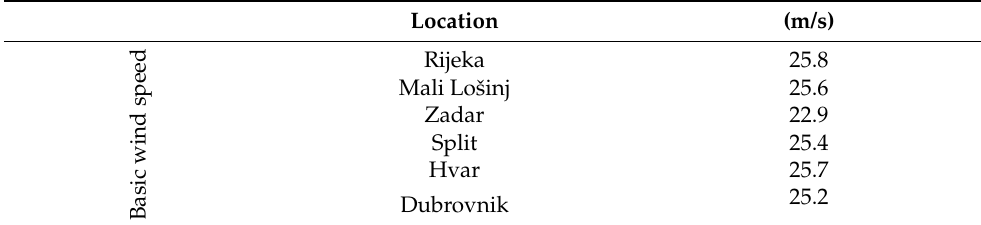
Table 6. Measured basic wind speed for six